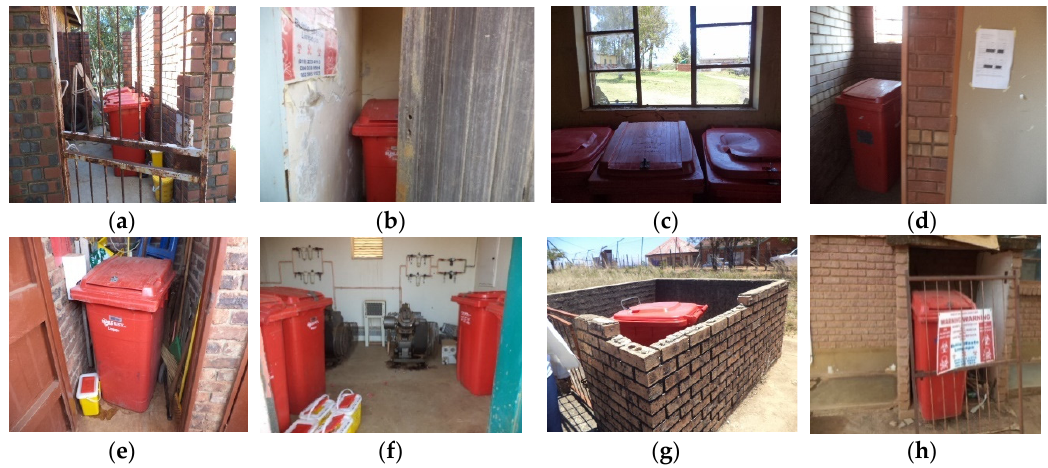
Figure 6. Photos taken by researcher during field work showing central storage areas for HCRW in Vhembe District Healthcare Facilities: HCRW storage rooms with doors, but, without locks ( a , b ); HCRW storage room without a door ( c ); HCRW stored in the same room with cleaning and gardening equipment ( d ); HCRW storage room with a broken window ( e ); an old incinerator room converted to storage area ( f ); HCRW storage area with a gate, a low fence but, without a roof ( g ); HCRW being stored by the corner of a wall, not in a secure room ( h ).